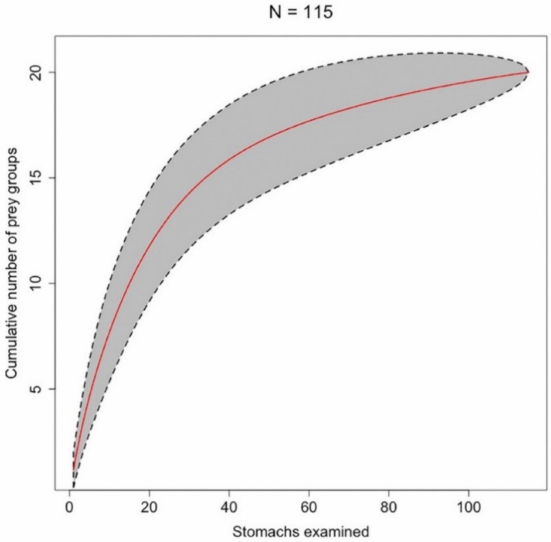
Figure 2. Cumulative prey curve ( in red ) as a function of sample size for all stomachs analyzed of Gobius paganellus . Standard deviation (SD) in grey delimited by dashed black